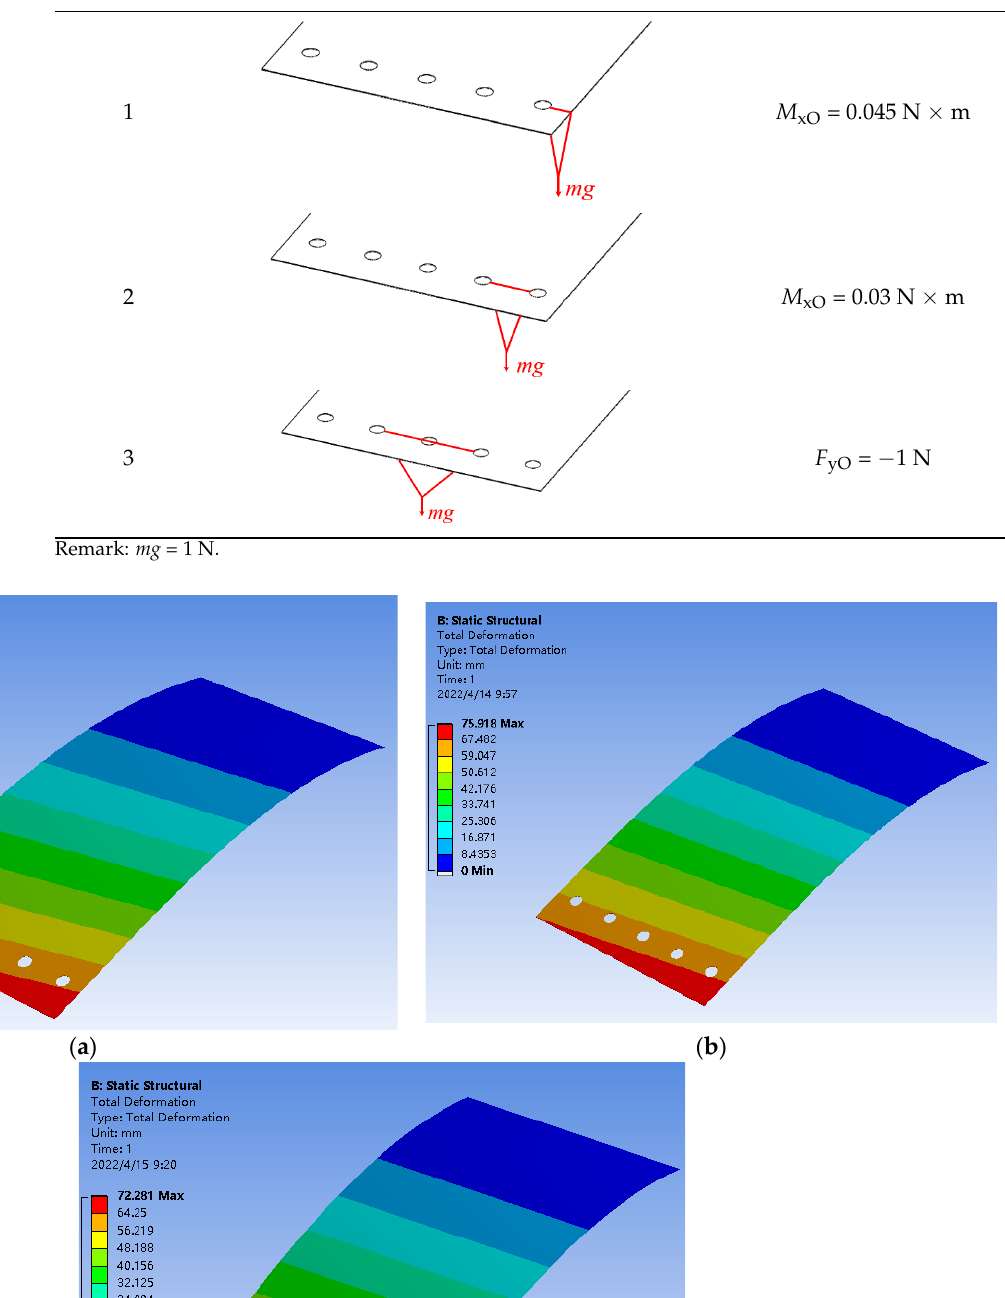
Table 6. Coordinates of points after deformation.